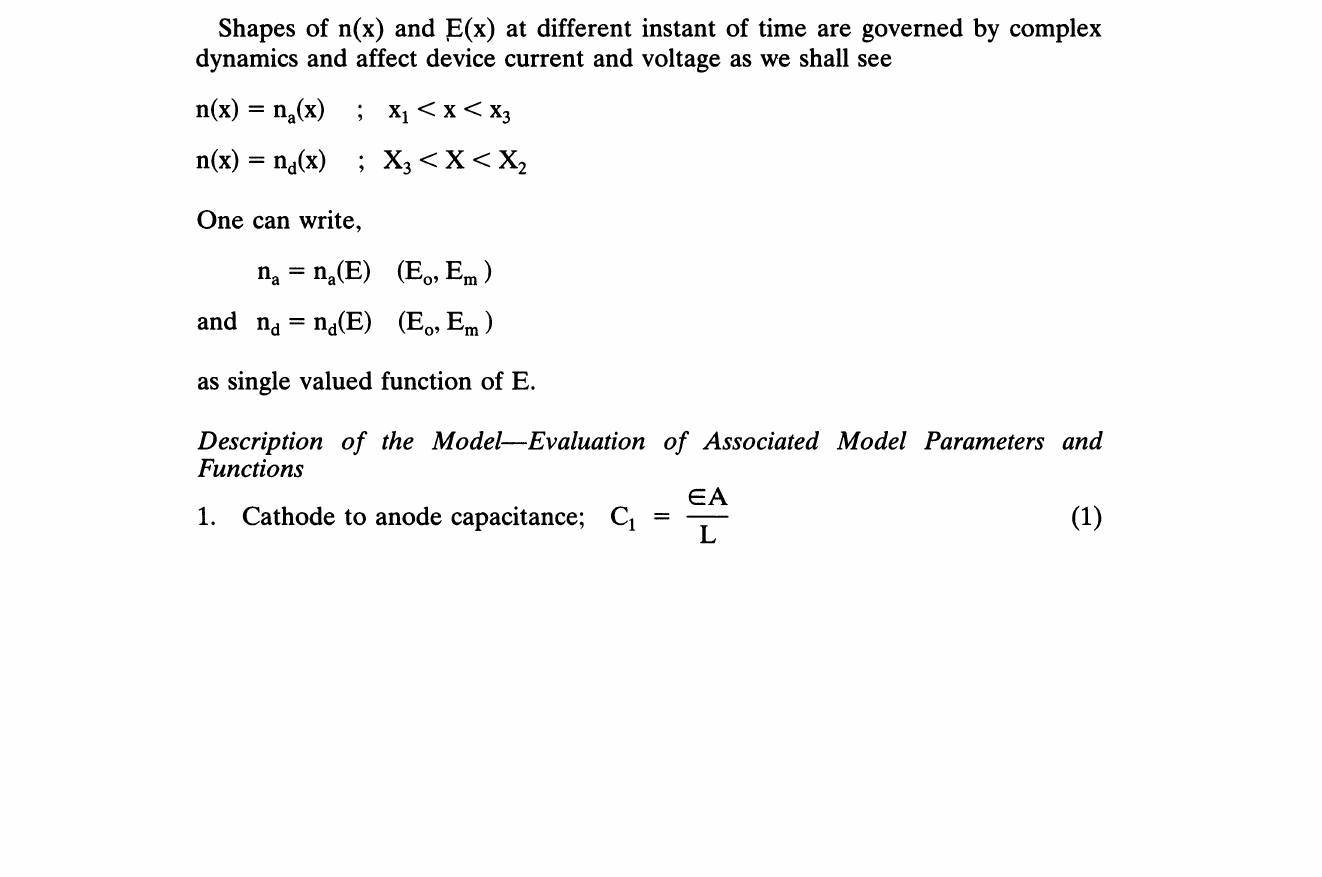
FIGURE 1 (a): A one-dimensional Gunn Diode (b): Carrier concentration at one instant of time (c); Electric field distribution inside Gunn Diode at one instant of